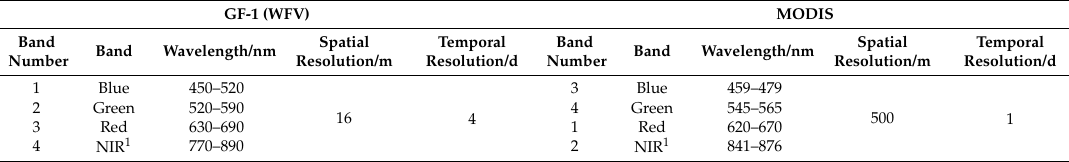
Table 1. Band information of GF-1 WFV and MOD09GA data.